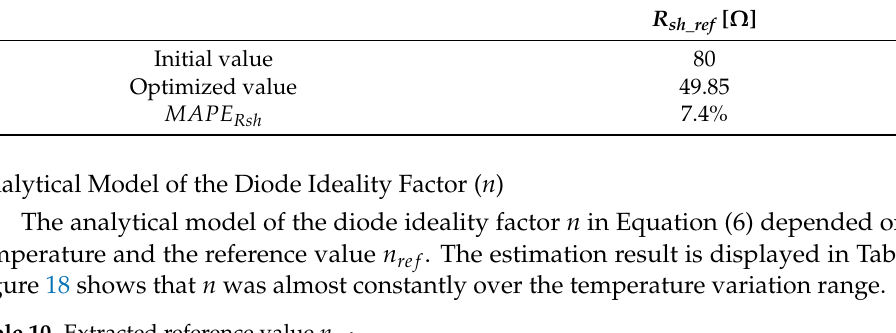
Table 10. Extracted reference value n ref